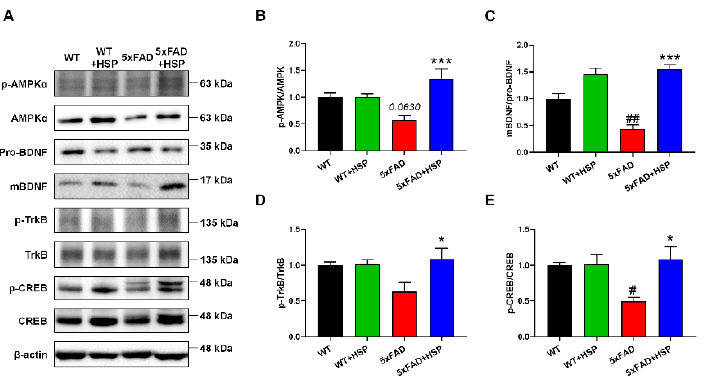
Figure 4. The effects of hesperidin on AMPK/BDNF/TrkB/CREB signaling in the hippocampus of 5xFAD mice. ( A – E ) Representative images of western blots ( A ) and quantification of AMPK ( B ), BDNF ( C ), TrkB ( D ), and CREB ( E ). Statistical analysis included one-way analysis of variance and Tukey’s post hoc test. # p < 0.05 and ## p < 0.01 compared with the vehicle-treated WT mice. * p < 0.05 and *** p < 0.001 compared with the vehicle-treated 5xFAD mice. Data are shown as mean ± SEM ( n = 4 per group).